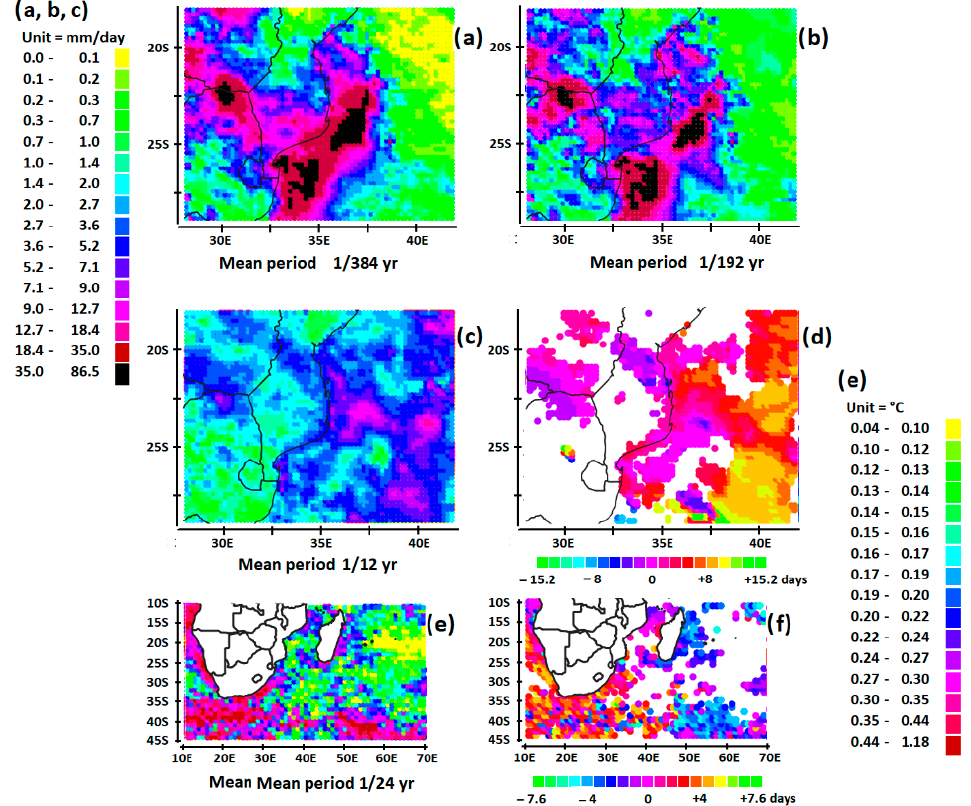
Figure 11. Extreme rainfall in Mozambique. Same conventions as in Figure 7. Time lags in ( d , f ) are expressed in relation to 22 February 2007. The time reference is the rainfall depth at 22 ◦ S, 49 ◦ E. Co-Evolution of SST and Rainfall Anomalies in Characteristic Period Ranges Clustering of mesoscale lows occurs in tune with the 1/12 harmonic while the phase shows a slow motion of the core of the low-pressure system oriented northwest–southeast (Figure 11c,d). SST anomalies between 0.44 and 1.18 ◦ C, which are a few days late on the ERE, develop along the Agulhas current as it flows south of the African continent before retroflecting when it meets the Benguela current flowing up along the southwestern coast of Africa (Figure 11e,f). Homogenization of the thermocline depth occurs in tune with the 1/24 harmonic (Figure